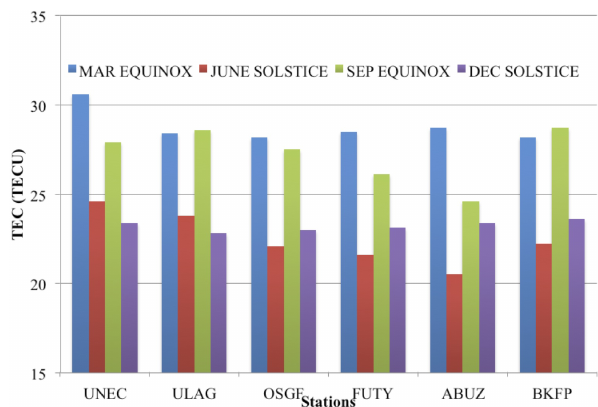
Figure 5. Seasonal TEC variations across some of the study areas in